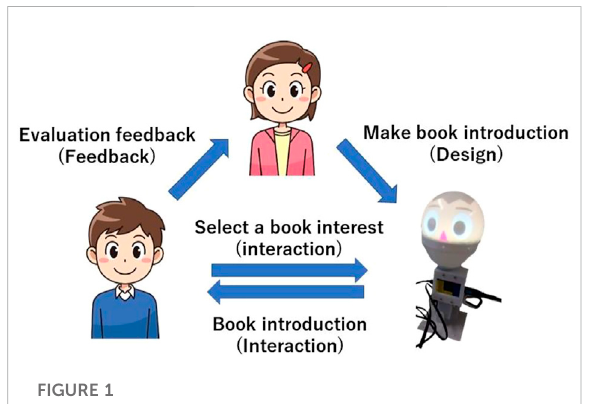
FIGURE 1 Interaction in user generated agent.